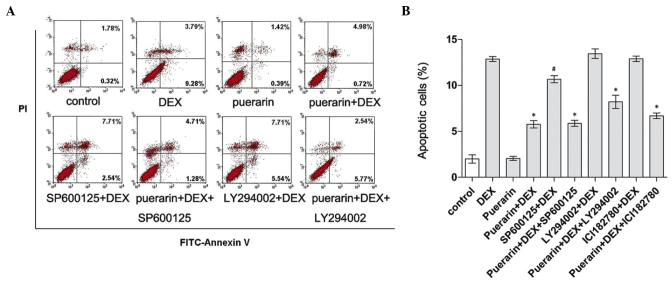
Effects of JNK and Akt on the apoptosis of hFOB1.19 cells. (A) Cells were treated with puerarin (10−8 M), SP600125 (10−5 M) or LY294002 (10−5 M) for 3 h prior to incubation with DEX (10−5 M) for 48 h. Flow cytometric analysis was performed following Annexin V-FITC/PI double staining. The upper left quadrant represents dead cells or debris, the upper right quadrant represents the late stage of apoptotic cells, the lower right quadrant represents the early stage of apoptotic cells and the lower left quadrant represented normal cells. (B) Levels of apoptosis of the hFOB1.19 cells were analyzed. Data are presented as the mean ± standard deviation. *P<0.01, vs. DEX; #P<0.05, vs. control. DEX, dexamethasone; FITC, fluorescein isothiocyanate; PI, propidium iodide.